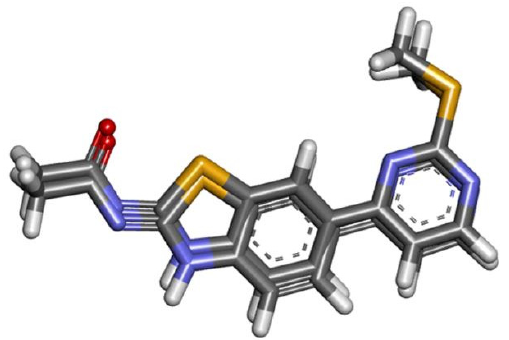
Figure 8. Re-docking of the active ligand at the PI3K site.